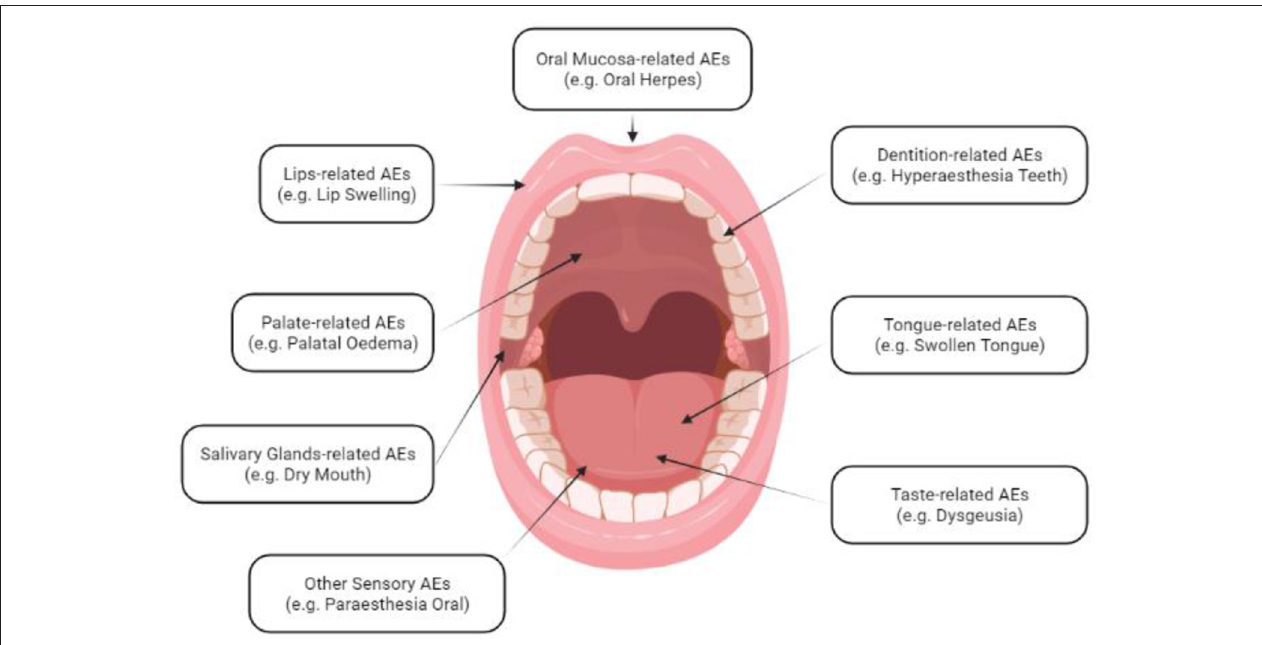
FIGURE 1 | Anatomo-physiological Scheme of Oral Adverse Events Following Immunization (AEFI); created in BioRender.com.